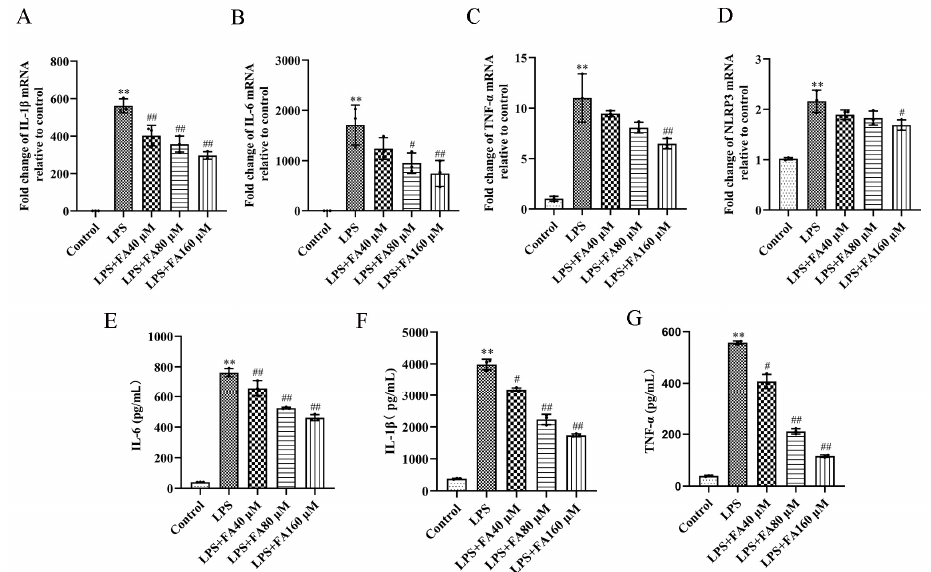
Figure 3. Effects of FA on the production of LPS-activated inflammatory cytokines in BV2 microglia BV2 microglia pretreated with different doses of FA for 2 h and then treated with 1 µ g/mL of LPS for 12 h. ( A – D ) The expression levels of IL-1 β , IL-6, TNF- α and NLRP3 were detected by reverse transcription-real-time quantitative PCR (qPCR). ( E – G ) The expression levels of IL-6, IL-1 β and TNF- α in the supernatants left by BV2 microglia were determined by ELISA. Data are means ± standard deviations (SDs) ( n = 3). ** p < 0.01, vs. control; ## p < 0.01, # p < 0.05, vs. LPS.